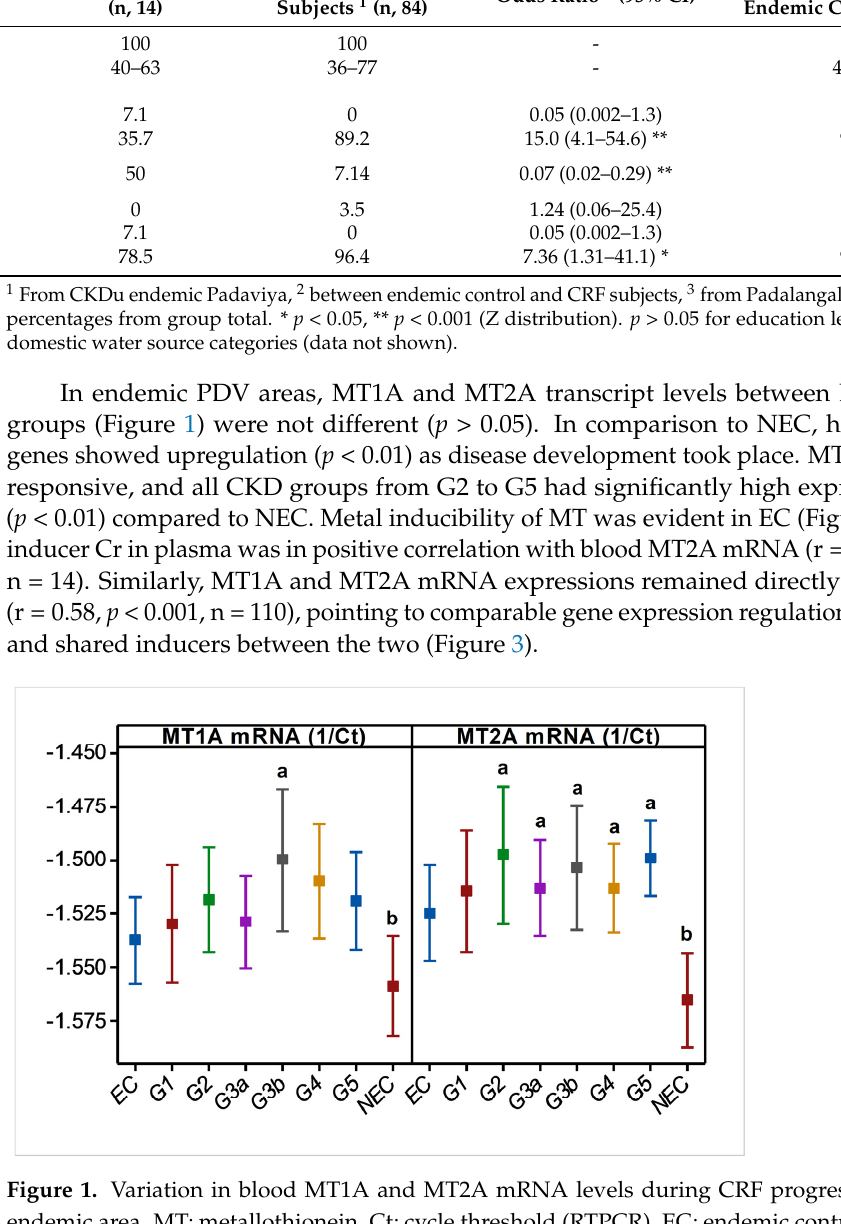
Figure 2. MT2A mRNA expression follows hMT inducer; Cr in individuals with good renal out- comes in CKDu endemic Padaviya area. Data were tested for Pearson’s correlation and plotted in linear scale axes.